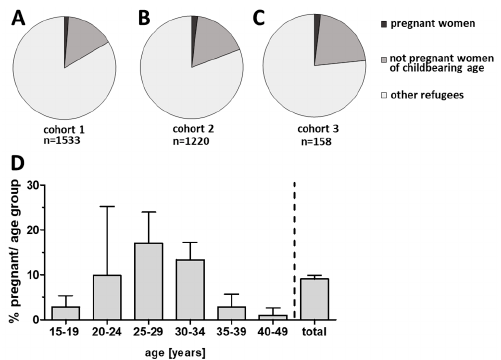
Figure 1. Proportion of women of childbearing age and pregnant refugees in cohort 1 ( A ) and cohort 2 ( B ), and cohort 3 ( C ). ( D ) Frequency of pregnant women among women of respective age groups and overall pregnancy rate among women of childbearing age in all three cohorts (total; bars display mean plus SD from all cohorts).